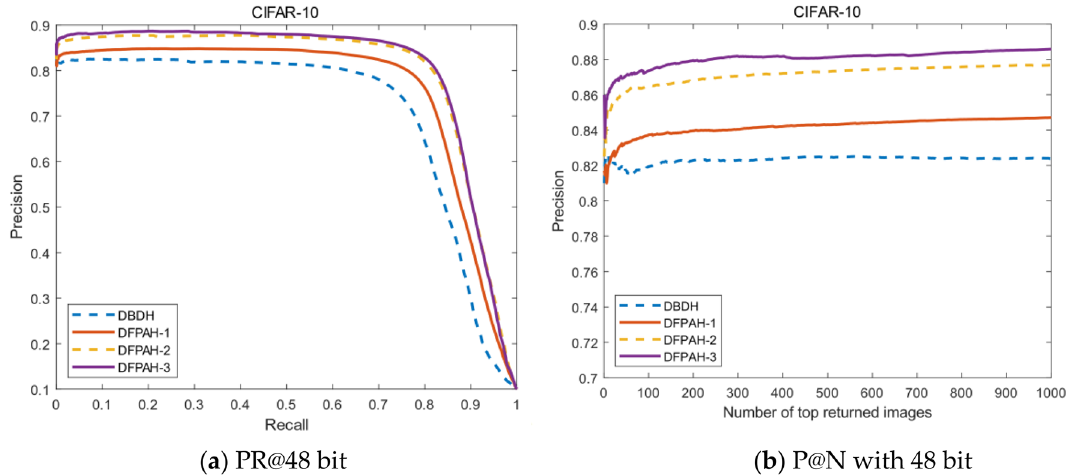
Figure 6. ( a,b ) Present the PR curves and P@N curves, respectively. (Created by “matlab R2019a” url: https:// ww2. mathw orks. cn/ produ cts/ matlab.